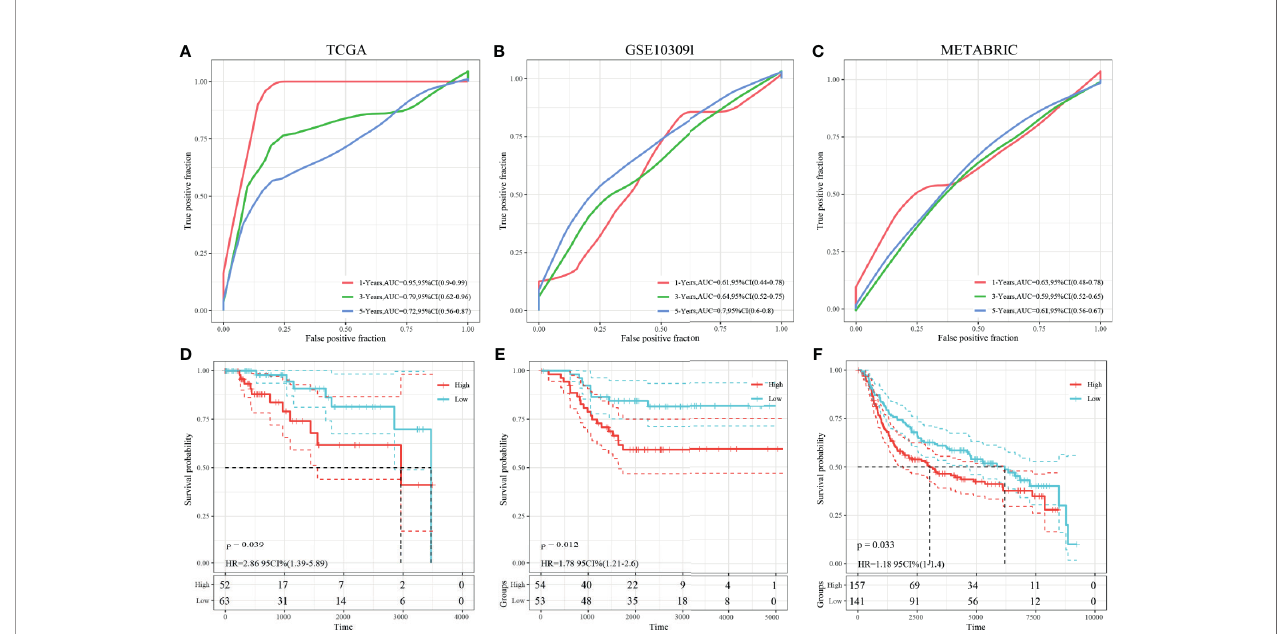
FIGURE 7 | Survival analysis, prognostic performance, and risk score analysis of the HRG-based score model in TNBC patients. The prognostic performance of 3-gene dHRG signature demonstrated by the ROC curve in the TCGA-TNBC cohort (A) , GSE103091 cohort (B) , and METABRIC cohort (C) . K – M survival analysis was performed to estimate the overall survival (OS) of high-risk and low-risk patients in the TCGA-TNBC cohort (D) , GSE103091 cohort (E) , and METABRIC cohort (F)